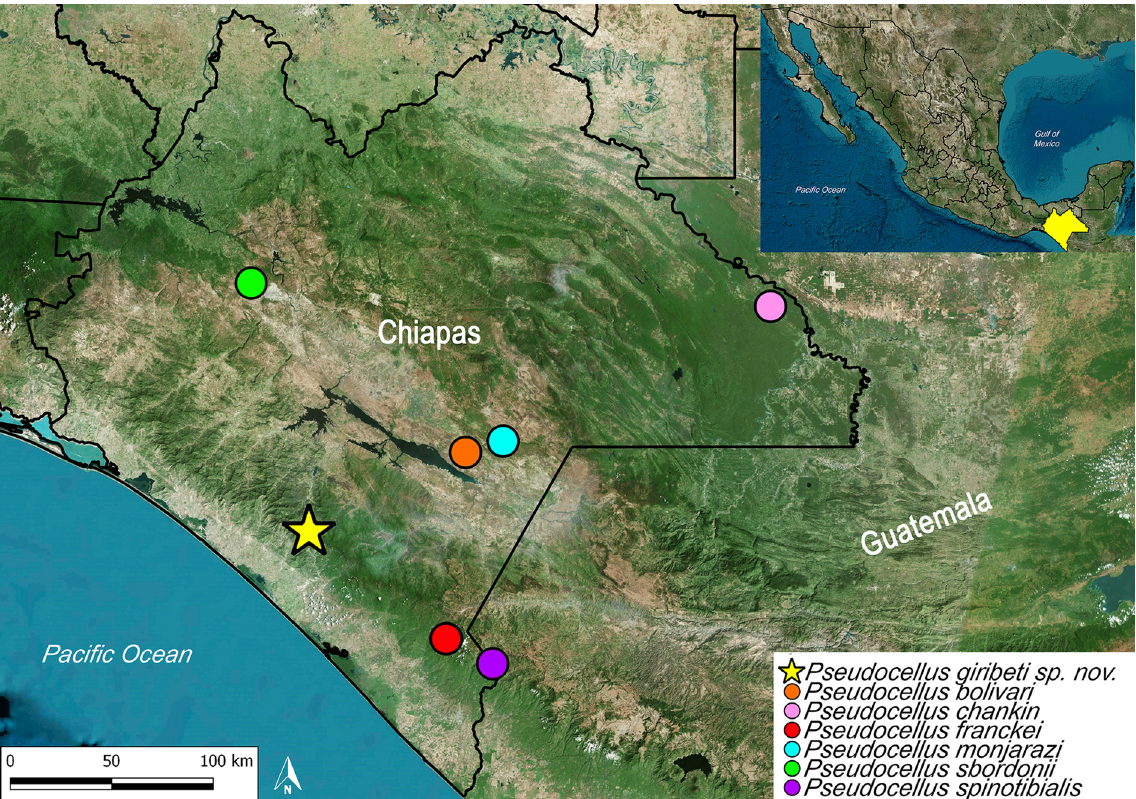
Fig. 36. Species of the genus Pseudocellus Platnick, 1980 described from Chiapas, Mexico, including the new species described herein. Star: El Triunfo Biosphere Reserve, El Quetzal Camp, Angel Albino Corzo Municipality. Red circle: Cerro Boquerón, Ejido Boquerón, Motozintla Municipality. Orange circle: Sumidero del Camino, 16 km NE of Comitán. Pink circle: Kolem-chen Cave “Cueva Grande”, Chan-kin Reserve, Ocosingo Municipality. Blue circle: San Francisco Cave, La Trinitaria Municipality. Purple circle: Finca Guatimoc, south slope of the Tacaná volcano, 32 km north of Tapachula, near Cacahuatán. Green circle: Las Abejas Cave, San Fernando